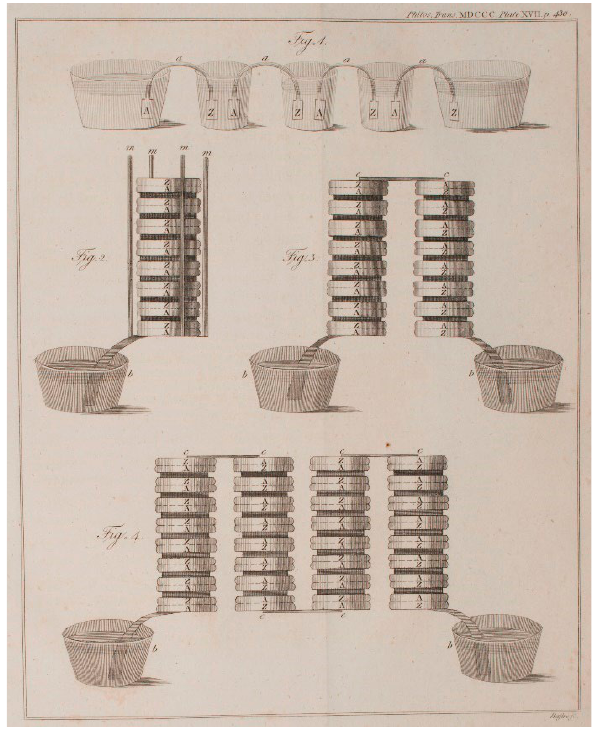
Figure 2. Alessandro Volta (1745-1827) (public domain). Figure 3. Volta’s crown of cups and several piles (public